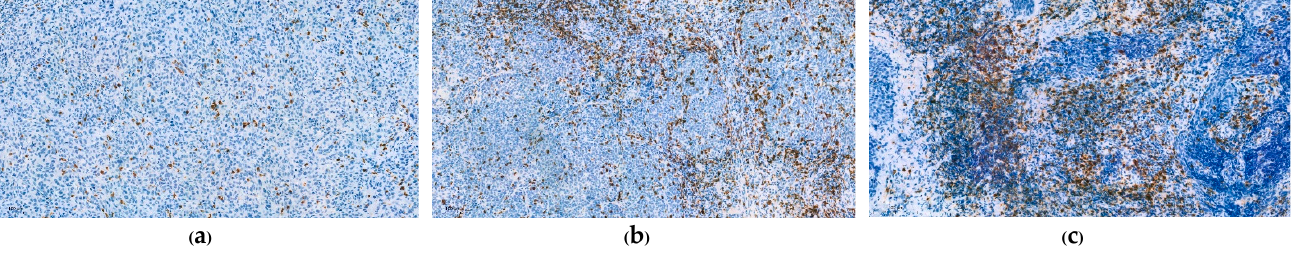
Figure 2 . Immunohistochemical staining for CD8 ( 100× ). ( a ) CD8 > 1 % but < 5 % ; ( b ) CD8 > 5 % but <10 % ; Figure 2. Immunohistochemical staining for CD8 (100 × ). ( a ) CD8 ≥ 1% but < 5%; ( b ) CD8 ≥ 5% but <10%; ( c ) CD8 ≥ 10%. ( c ) CD8 > 10 %.